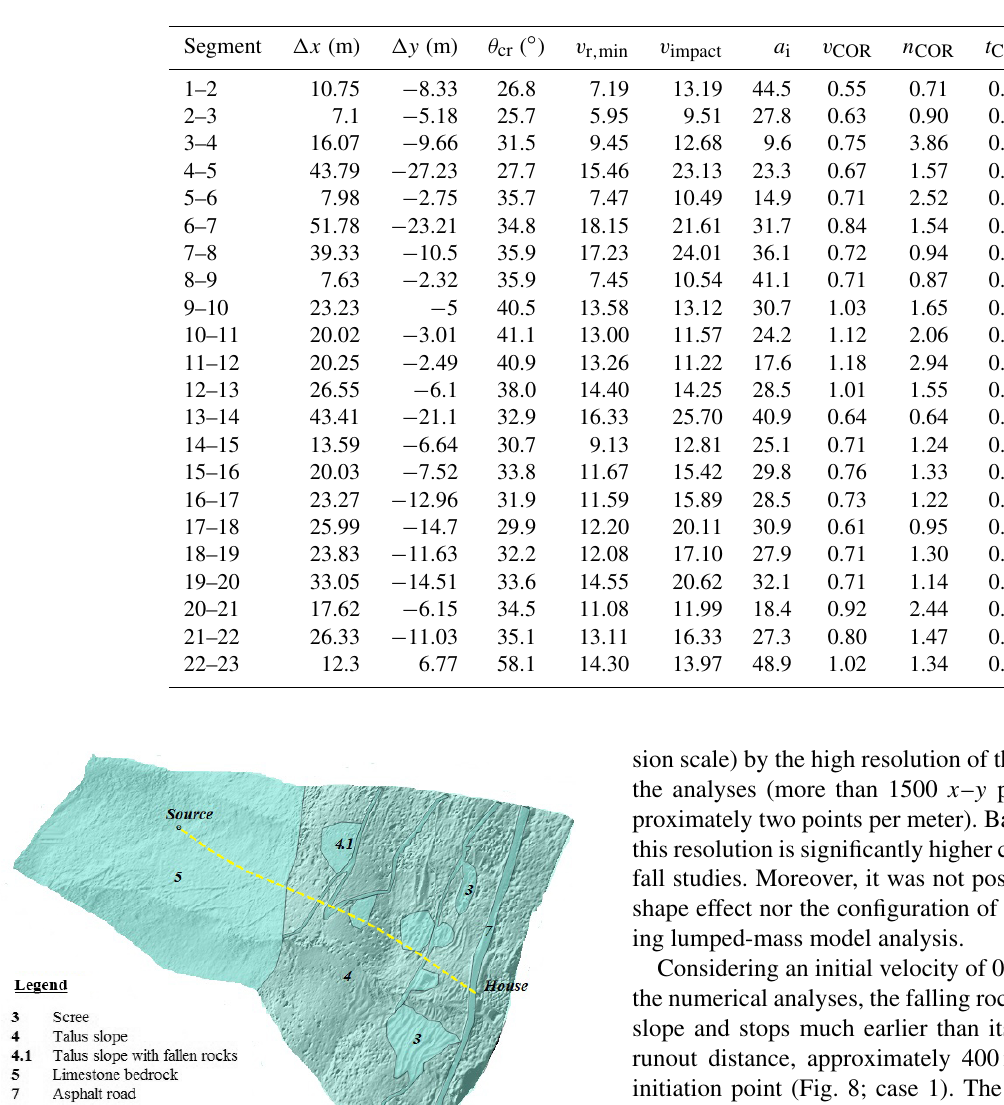
Table 3. Parabolic paths characteristics for the minimum release velocity.